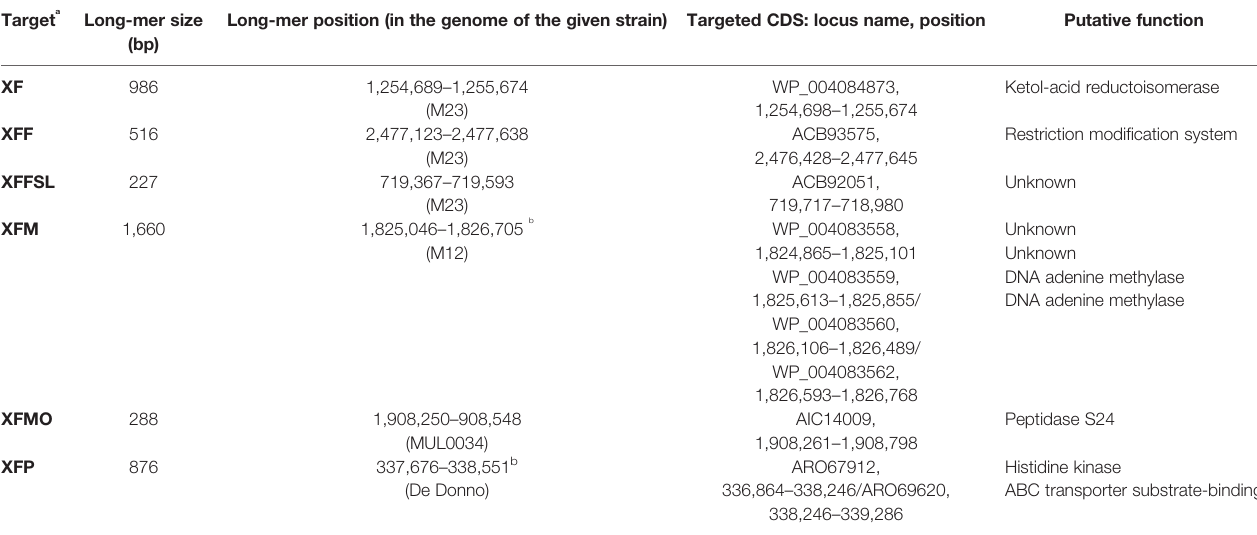
a : See Table 3 for description of codes of primer and probe sets. b : The long-mer is overlapping several